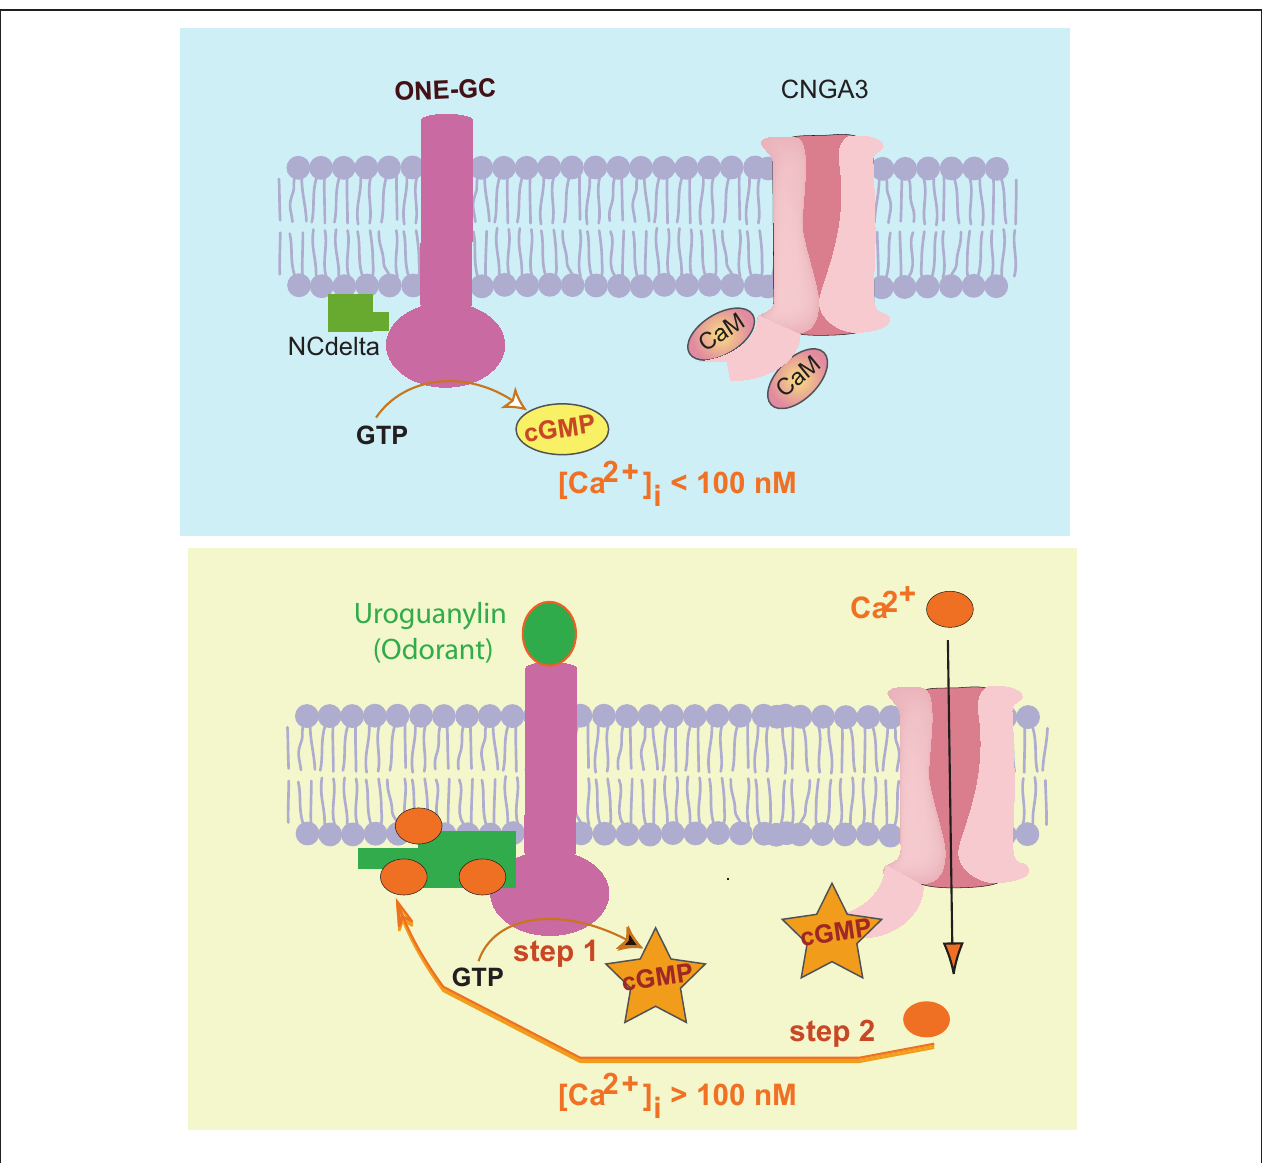
FIGURE 5 | Two-step uroguanylin-neurocalcin δ signal transduction model. Upper panel : Resting state (free [Ca 2 + ] i < 100nM). ONE-GC is in its basal state, is bound to Ca 2 + -free neurocalcin δ (NCdelta) with low affinity, and maintains the steady-state cyclic GMP concentration. Calmodulin (CaM)-bound cyclic GMP-gated Ca 2 + channel (CNGA3) is closed. Lower panel : “Step 1,” uroguanylin interacts with the receptor